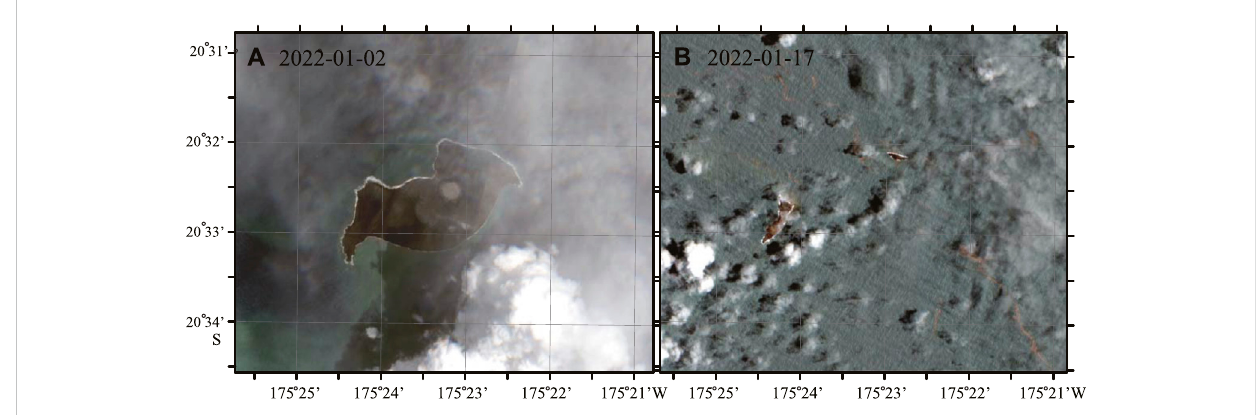
FIGURE 2 Sentinel2A/B satellite images obtained (A) on 2 January 2022, before the volcanic eruption and (B) on 17 January 2022, after the volcanic eruption. The white curve area is plotted based on the outline of the island area above the ocean surface on 2 January